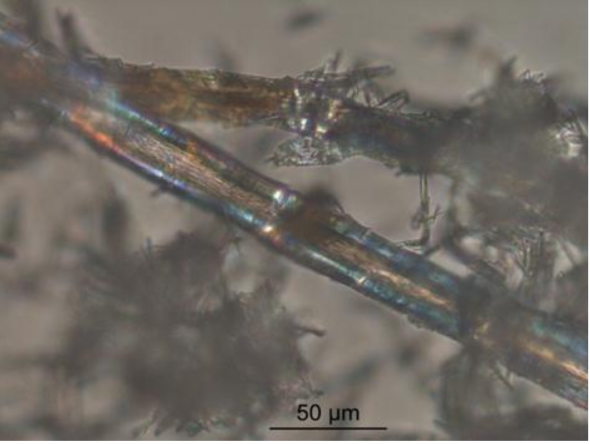
Figure 2. Threadlike nanocrystals of ettringite.